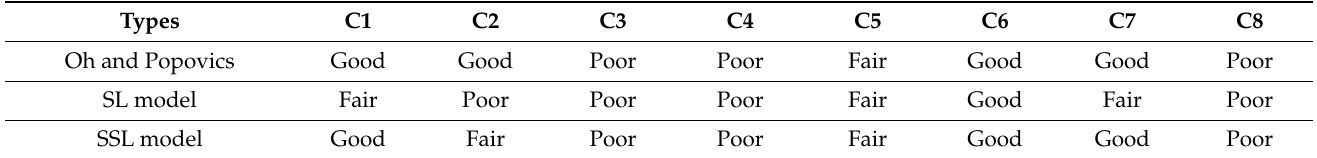
Figure 14. Eight drilled core samples, C3, C4, and C8, contain horizontal delamination at the top bar depth (image credit: Nenad Gucunski).